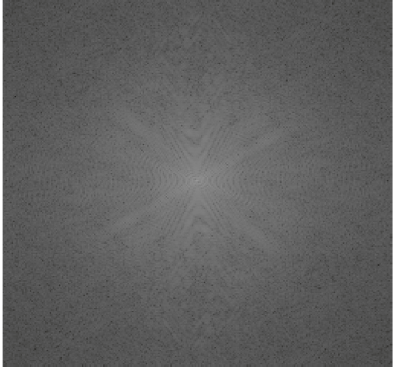
Figure 2: Brain BMP scan base image.